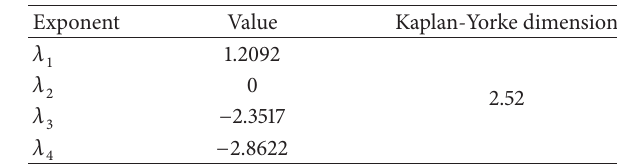
Table 5: Lyapunov exponents